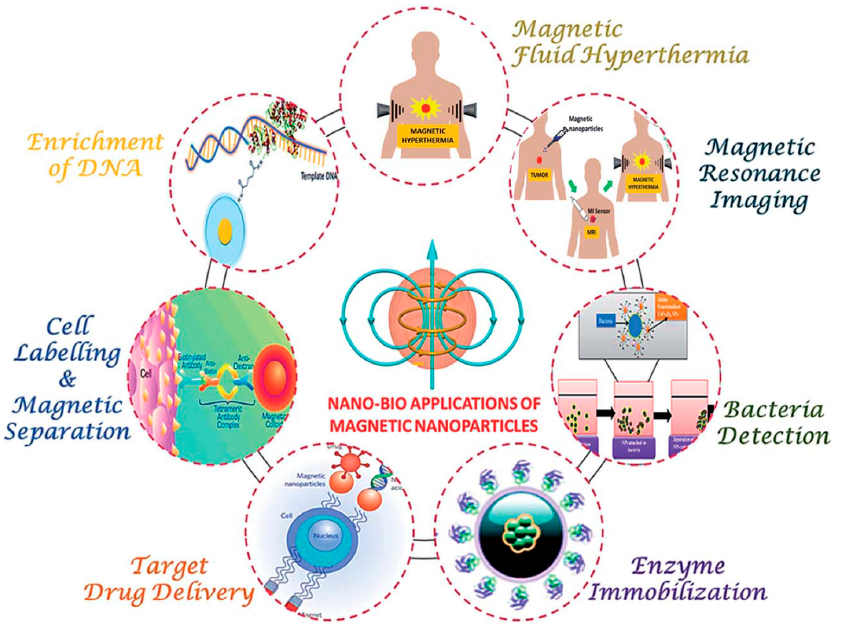
Figure 3. Different biomedical applications of magnetic nanoparticles—schematic presentation. (Adopted from RSC Adv. 2016 , 6 , 43989–44012 with permission.)